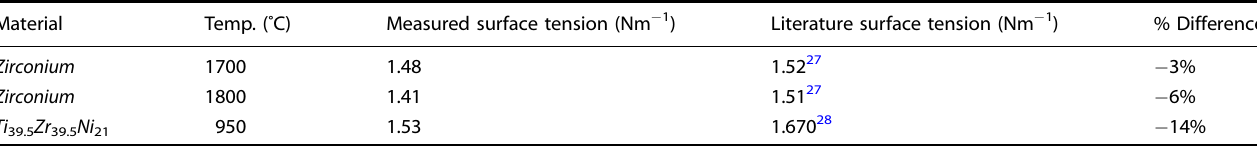
Table 1. Comparison of surface tension results using the Faraday forcing method from Brosius et al. 15 and existing literature values using the pulse-decay technique.